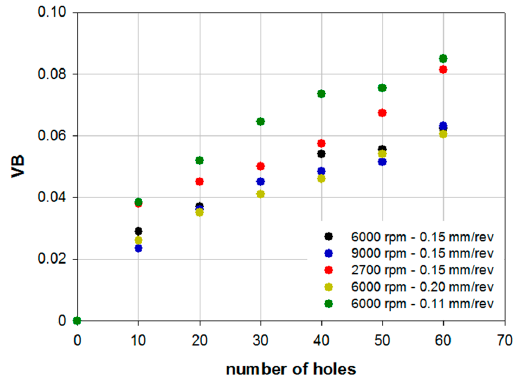
Figure 5. Measured flank wear VB vs. hole number for diverse drilling conditions.